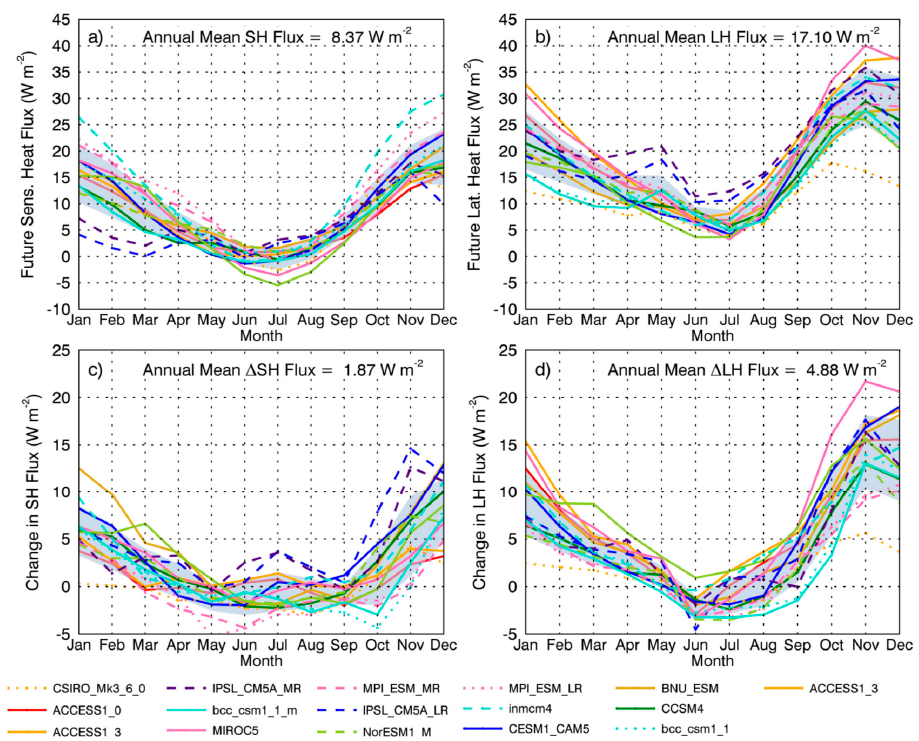
Figure 13. Top panels show the projected annual cycle of future ( a ) SH and ( b ) LH fluxes averaged over all non-land gridboxes poleward of 60° N for RCP8.5 during the future period for 16 CMIP5 models. Bottom panels show the ( c ) SH and (d) LH flux differences between the future and present-day periods. Present-day is defined as the first 20 years of the simulation (2006–2026) and future is defined as the 20-year period between 2080 and 2100. Table 4. Present-day (2006–2026) and projected changes (2080–2100 minus present-day, signified by Δ ) in surface temperature (T s ), near-surface air temperature (T a ), SH, LH, and sea ice concentration (SIC) averaged across all non-land gridboxes in the Arctic domain (60°–90° N) for 16 CMIP5 climate models using the RCP8.5 forcing.